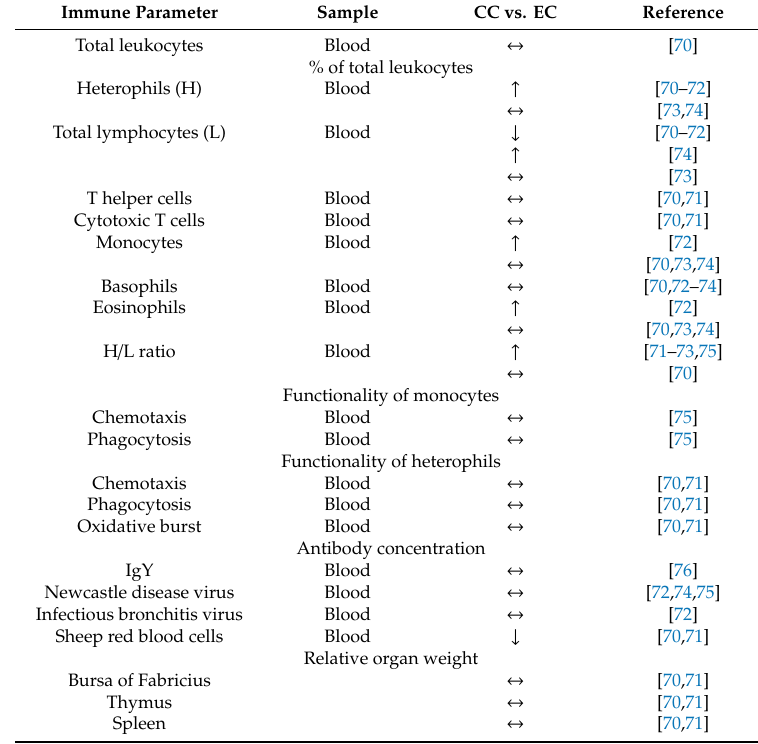
Table 1. Alterations of immune parameters of chickens housed in conventional cages (CC) compared to enriched cages (EC). Immune Parameter Sample CC vs.